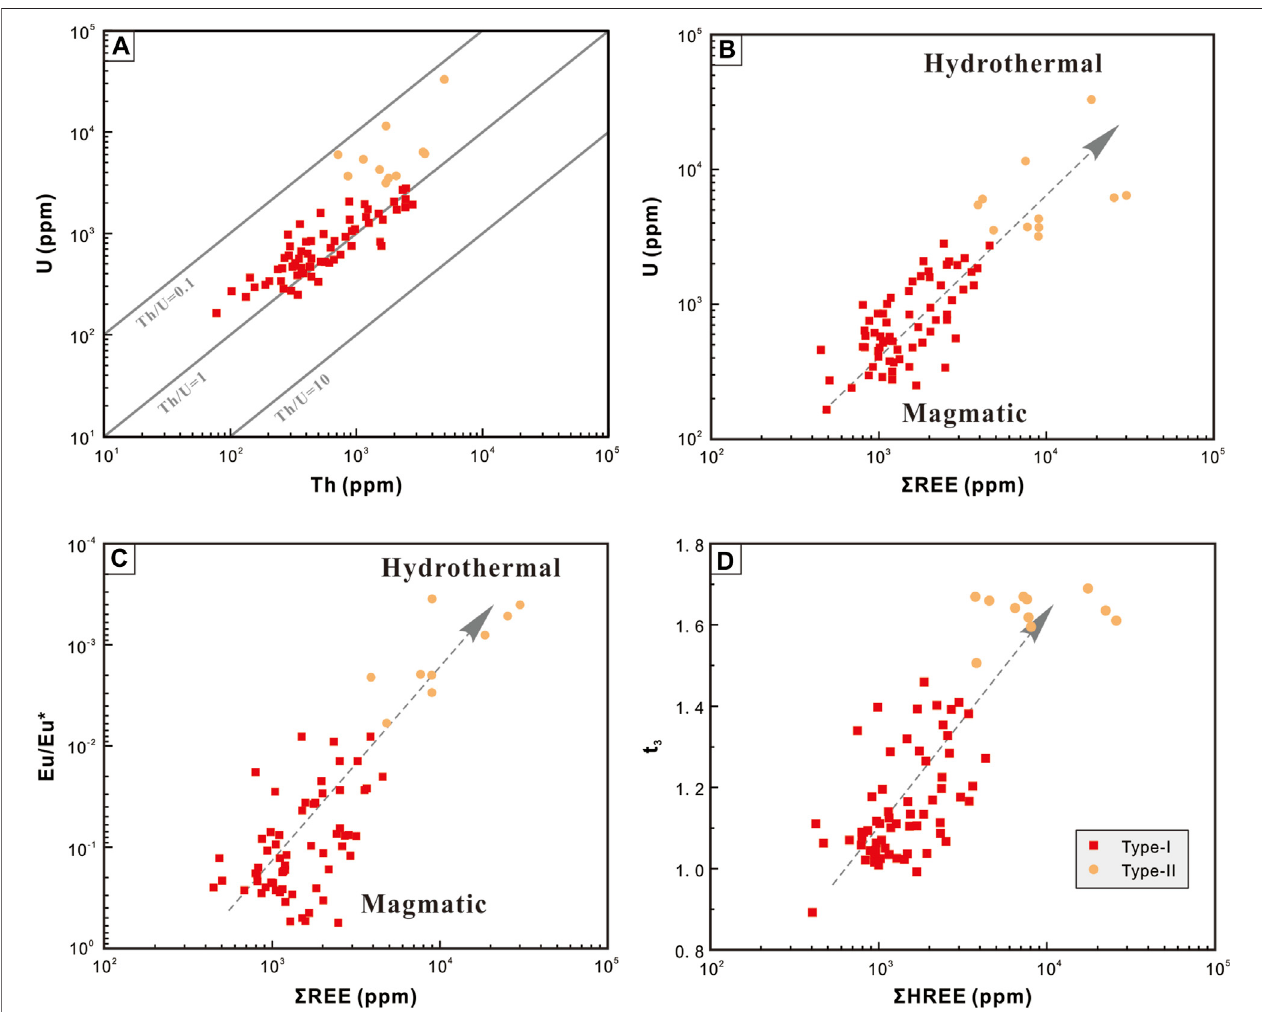
FIGURE9| Plotsof (A) Uvs.Th, (B) Uvs. (cid:1) REE, (C) Eu/Eu*vs. (cid:1) REE,and (D) comparisonofquanti fi cationfactort 3 to (cid:1) HREEoftwotypesofzirconfromtheBST pluton. All data come from Supplementary Appendix Table 4 .